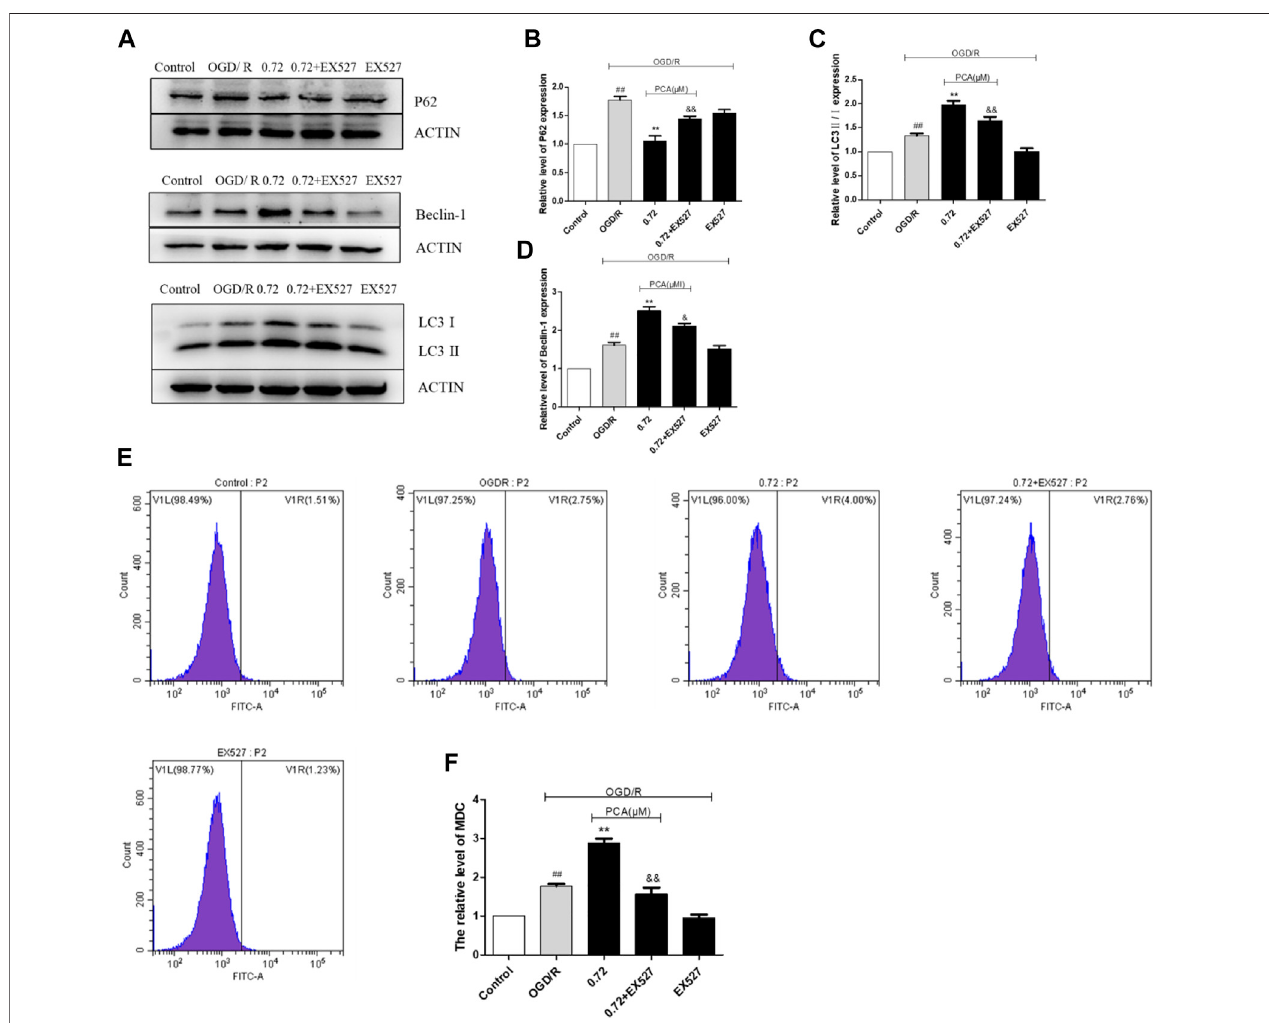
FIGURE10| InhibitionofSIRT1byEX527attenuatesthepro-autophagyeffectofPCA. (A – D) RepresentativeimagesofWBanalysisandthesemi-quanti fi cationof P62, Beclin-1 and LC3 in HUVECs. (E, F) Representative images of fl ow cytometry analysis of PCA in fl uence and quanti fi cation of cell autophagy rate. The values are expressed as the mean ± SD ( n = 3). ## p < 0.01 vs. Control, ** p < 0.01 vs. OGD/R, && p < 0.01, & p < 0.05 vs. PCA 0.72 μ